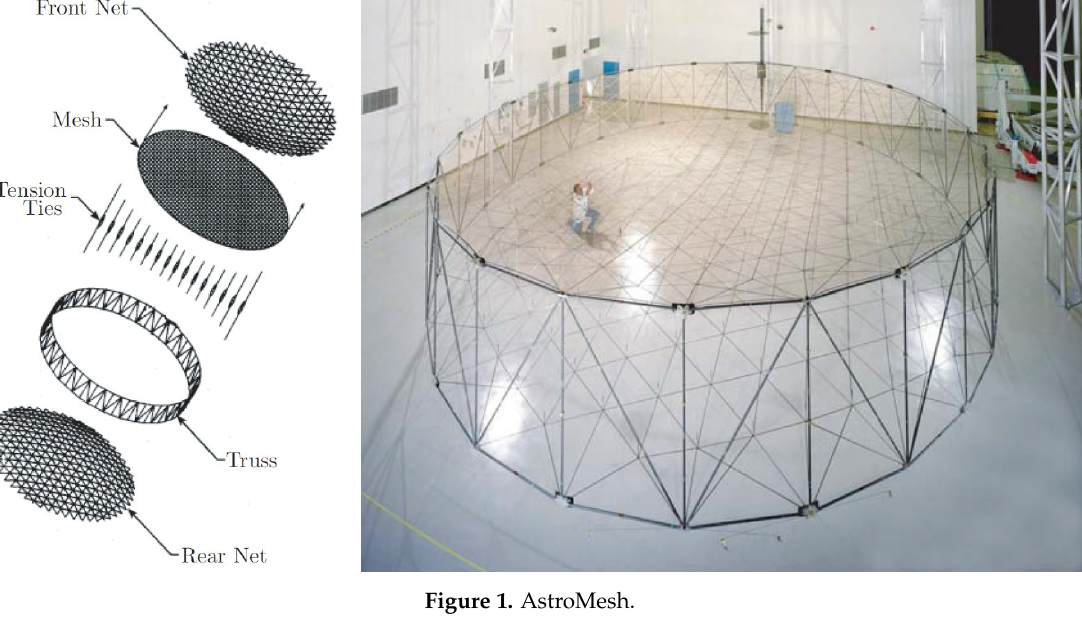
Figure 1. AstroMesh.